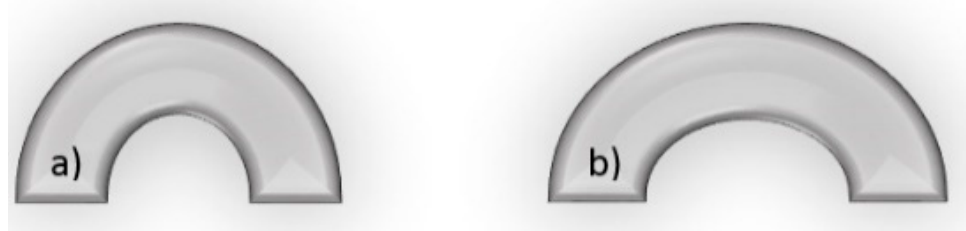
Figure 4. Crown design: ( a ) low and ( b ) high radius of curvature in the middle area of the crown.